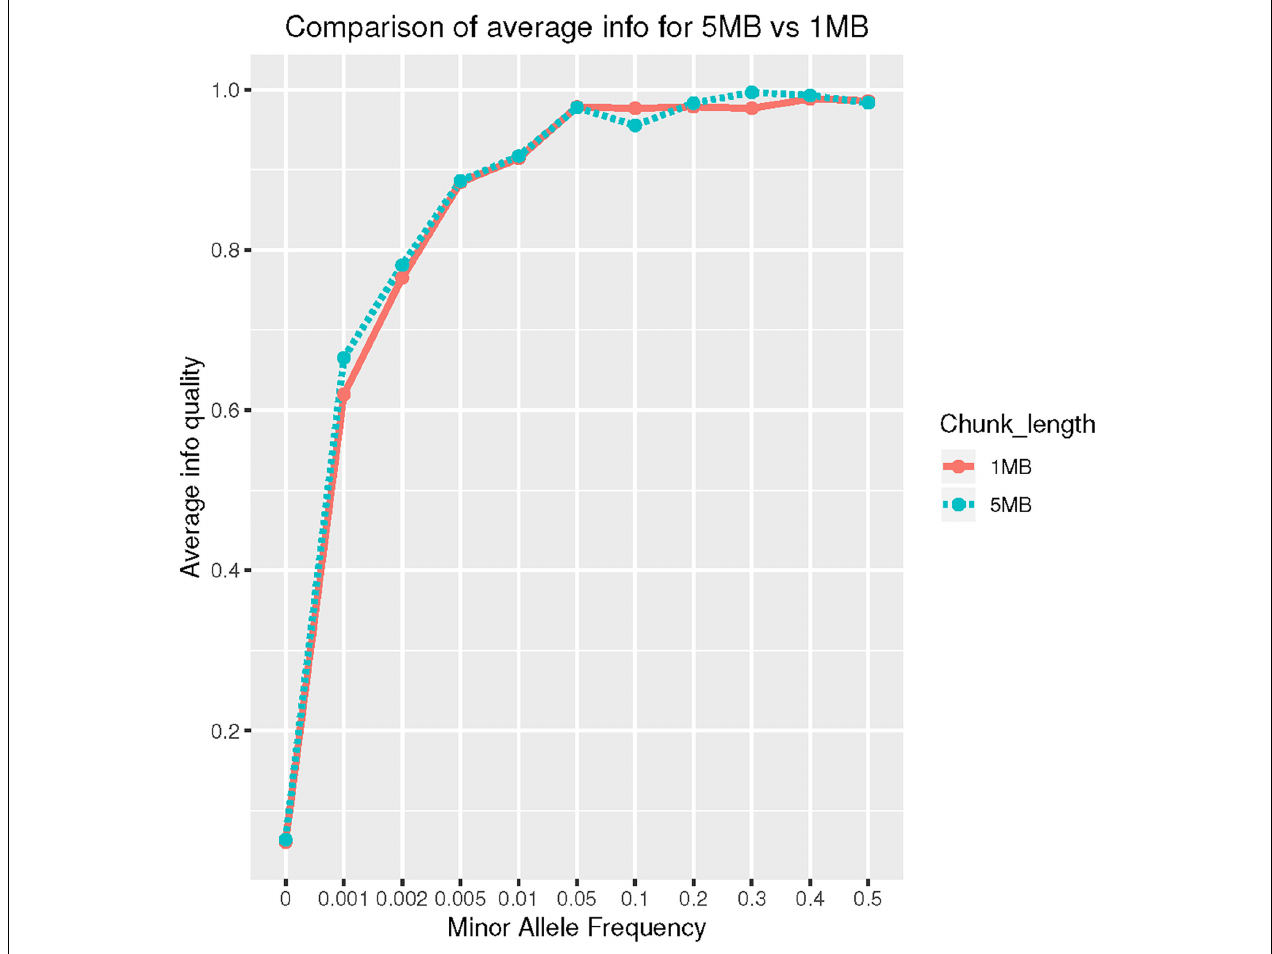
FIGURE 2 | Comparison of average Info on CHR14: 70–75 MB (5 MB) vs. 73–74 MB (1 MB)